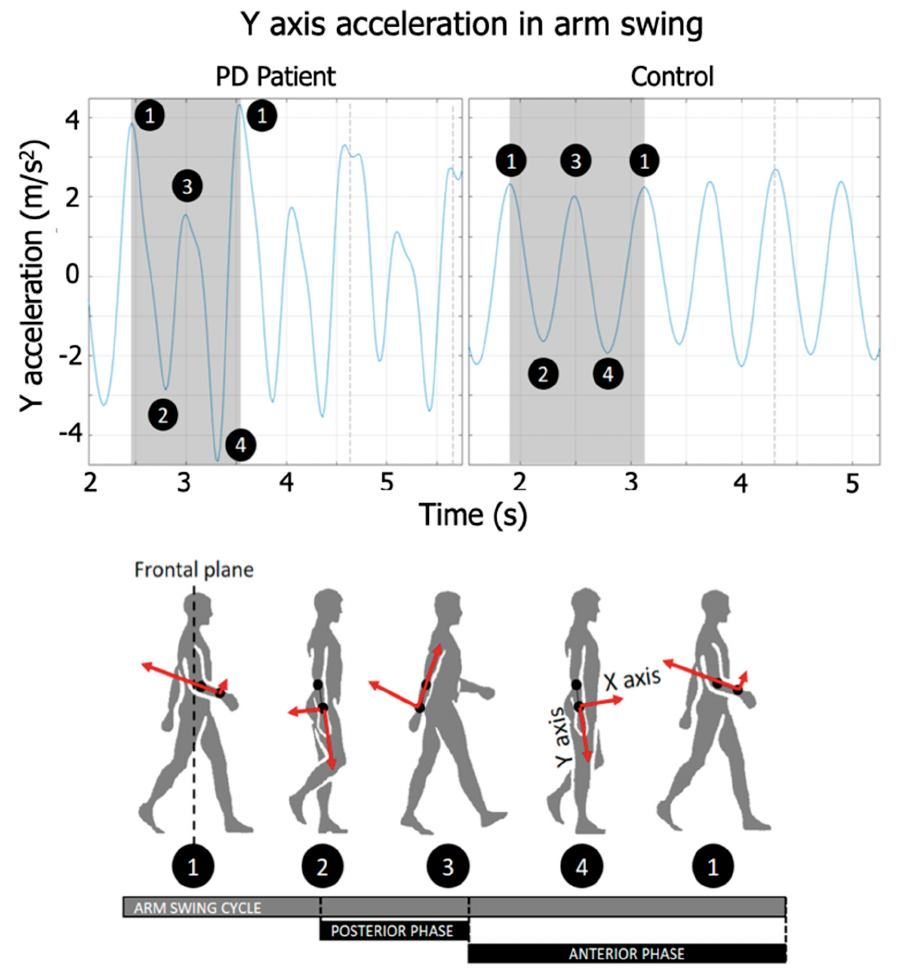
Figure 4. 1–2–3–4–1 represents all phases of a complete gait cycle. 1–2–3 are representations of